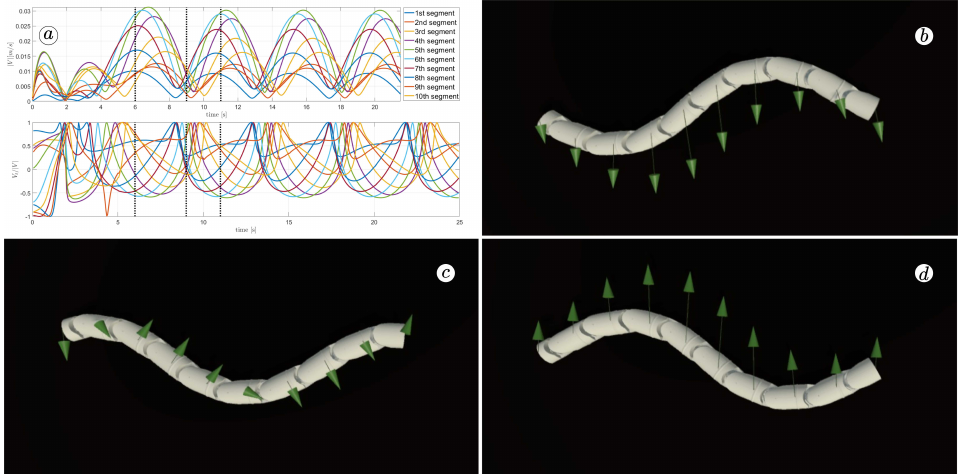
Figure 19. Absolute value and tangential component of segments velocities for c t = 10 and c n = 10 ( a ) and velocity vectors for t = 6 ( s ) ( b ), t = 9 ( s ) ( c ), and t = 11 ( s ) ( d